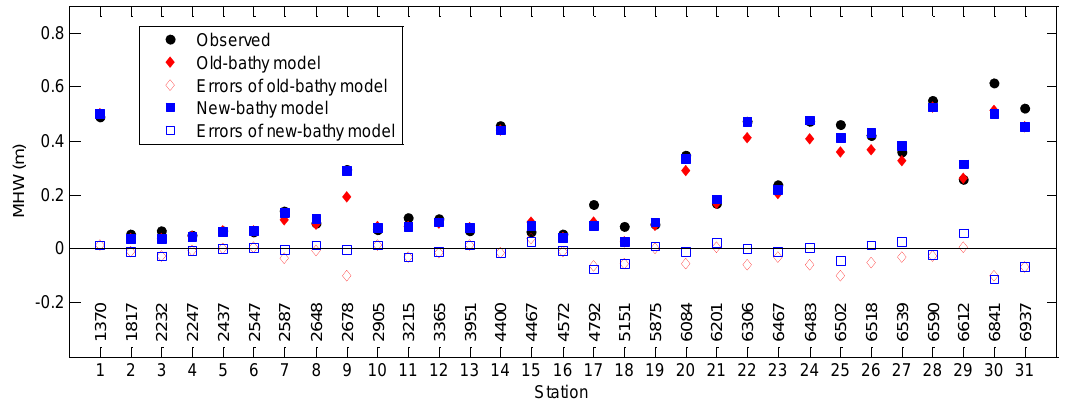
Figure 6. Comparison of MHW at 31 NOAA stations between the observations (black dots), the old-bathy model (red solid diamonds), and the new-bathy model (blue solid squares). The blank diamonds and squares indicate the model errors.